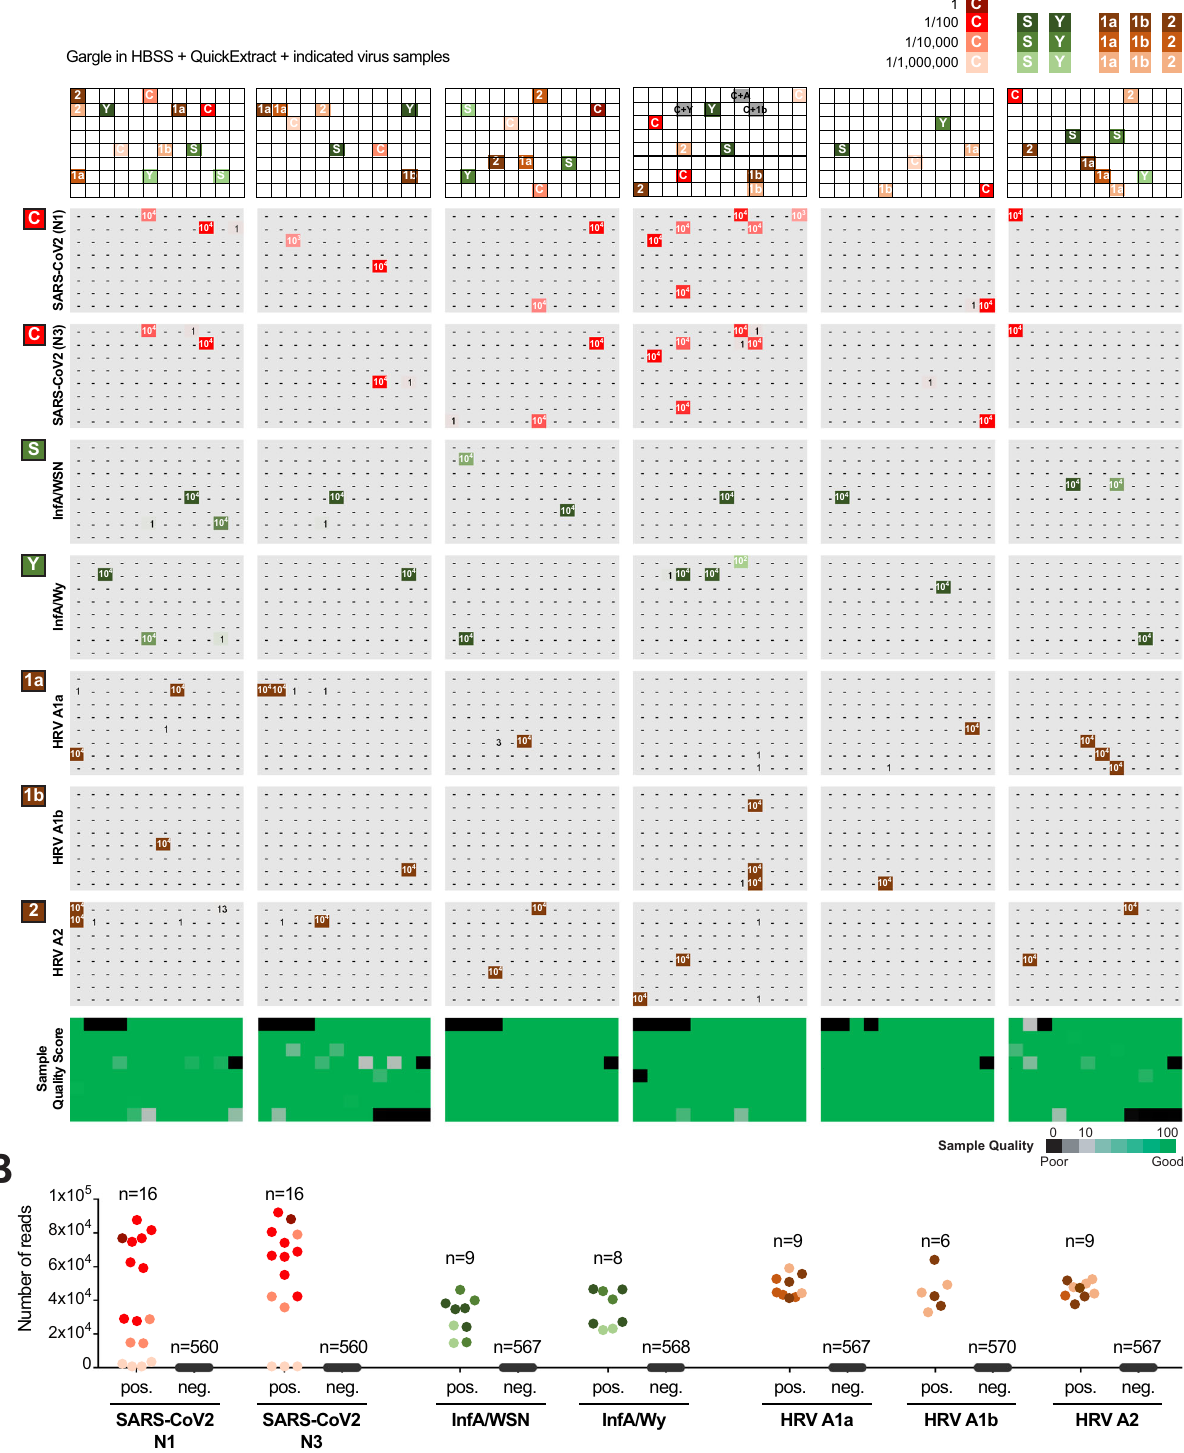
Fig. 5 SARSeq can detect multiple respiratory viruses in a single reaction. A Six 96-well plates fi lled with gargle in HBSS and inactivated in QuickExtract from our in-house pipeline were spiked with RNA from various respiratory viruses. For SARS-CoV-2, a positive gargle sample with Ct value of 30 was diluted as indicated. RNA for all other viruses was obtained from HEK cells 48 h after infection with the virus. Dilution indicated by voluminometric ratio. SARSeq was performed with six primer pairs in one reaction, namely N1 and N3 for SARS-CoV-2, In fl uenza A virus, human rhinovirus (HRV), and the ribosome. In fl uenza A substrains and HRV substrains were distinguished based on amplicon sequence variants. B Analysis of false-positive and false- negative rate of the experiment in panel A . As expected, 1:100,000 dilutions of the SARS-CoV-2 sample with a Ct of 30 were missed. All other positive samples were detected for all viral